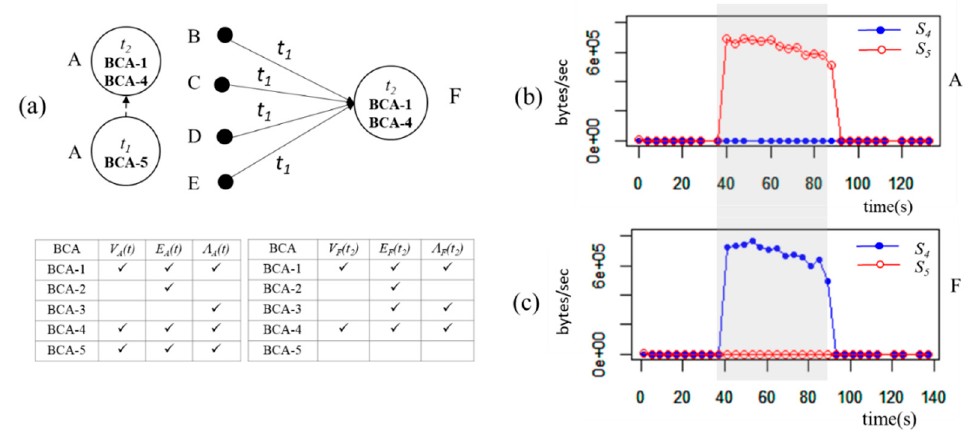
Figure 10. ( a ) Network structure of Scenario 4 and the BCA status of host A and F . ( b , c ) Experimental results of S 4 and S 5 on host A and F .